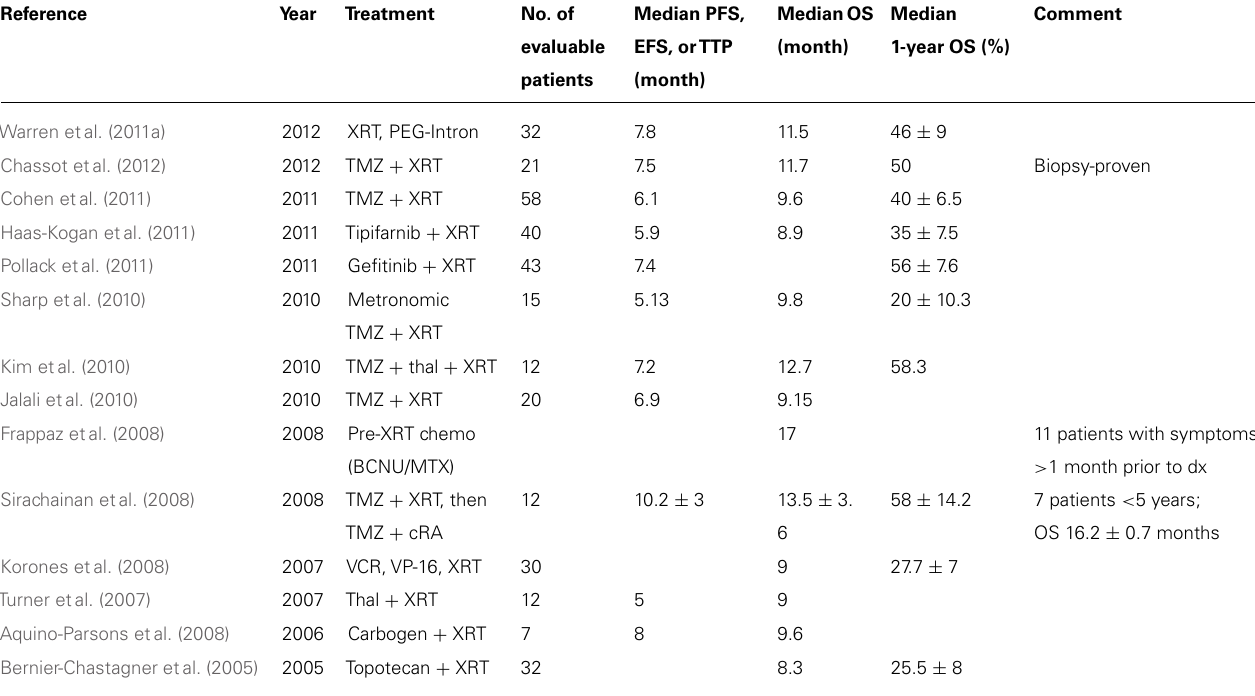
Table 1 | Results from recent phase II or non-dose-escalating trials (e.g., pilot) for DIPG. Reference Year Treatment No. of